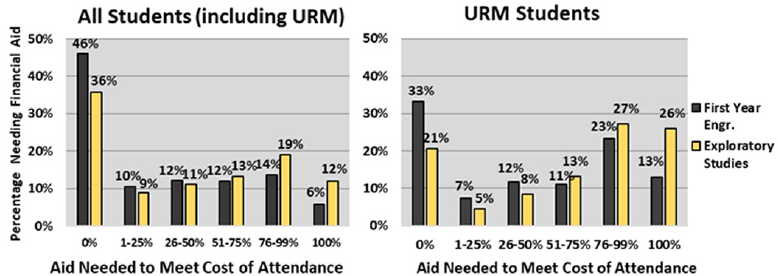
Fig. 1. Financial need compared between engineering and exploratory studies students at Purdue University (2012–2015)